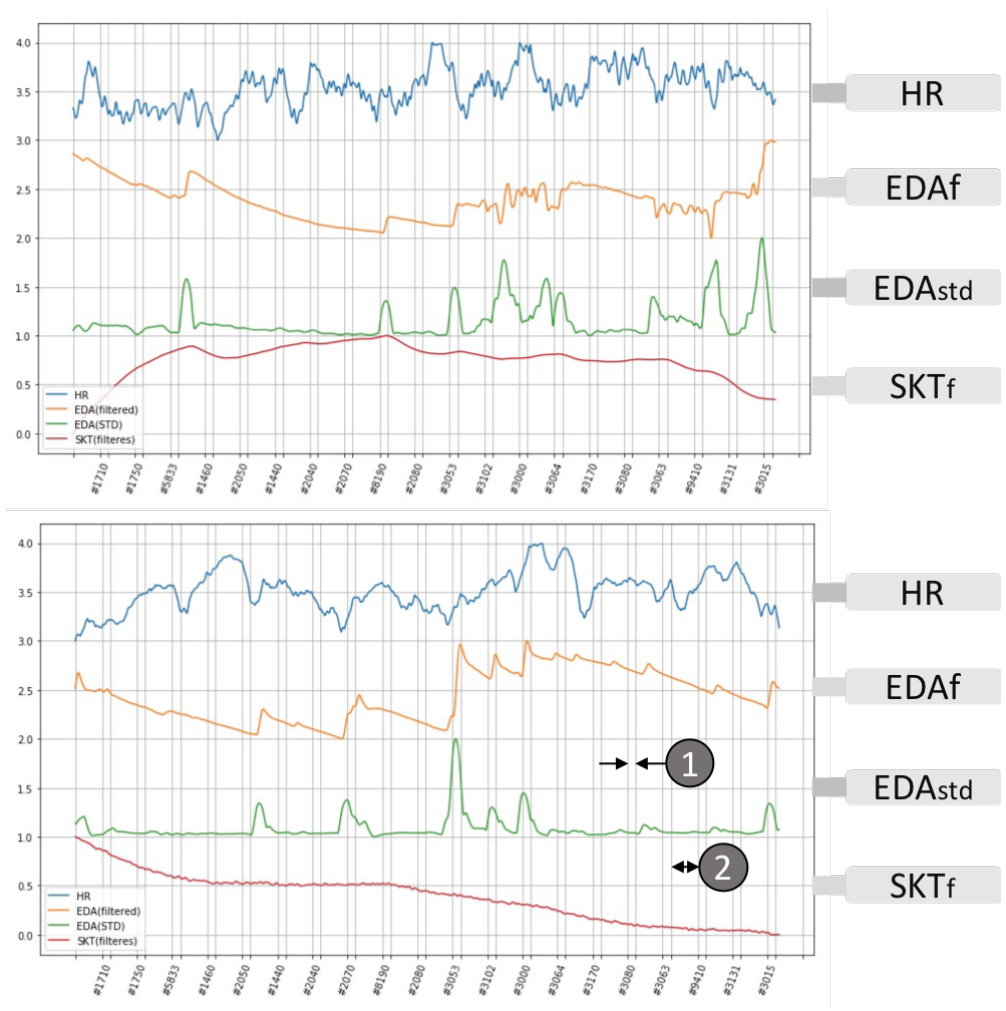
Figure 3. Physiological responses for still picture stimuli (IAPS). Each study session of emotion recognition using IAPS stimuli lasts a total of 520 s; the 20 chosen pictures in two categories listed in Table 2 are shown as still images on the display in sequence of six seconds per image 1 (cid:13) , and the gaps between images are each filled with a 20-s black screen 2 (cid:13) . The x-axis shows the arrangement of the two categories of IAPS pictures according to their unique reference numbers. All participants showed unpleasant emotion when the first negative valence picture was displayed (#3053). The upper picture shows a higher heart rate deceleration during the switching of emotional valence, and the lower picture depicts a more significant skin conductance